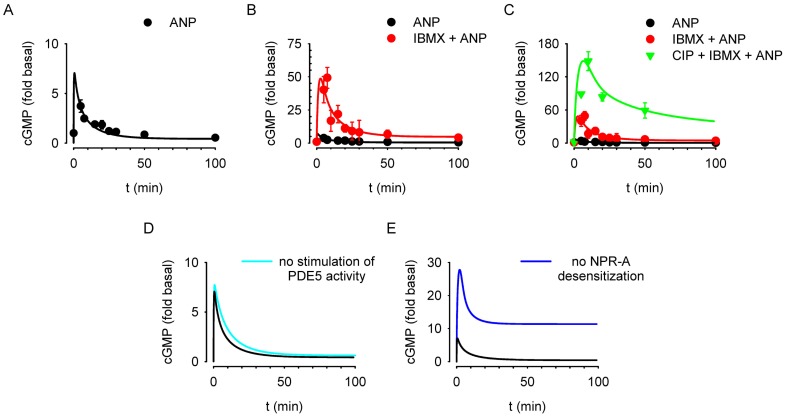
Mathematical simulations of the schematic model describe observed cGMP signals in MA-10 cells.The model well describes transient cGMP signals triggered by ANP alone (A, black trace), IBMX and ANP (B, red trace), and CIP, IBMX, and ANP (C, green trace). (D,E) Simulations in which ANP-mediated stimulation of PDE5 activity (D) or NPR-A desensitization (E) were blocked demonstrate the importance of receptor desensitization in regulating ANP-mediated cGMP signals.